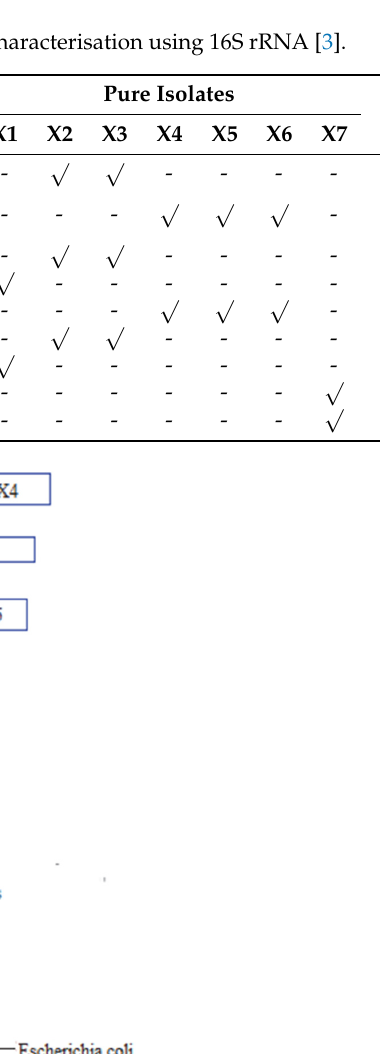
Table 3. Sludge Cr(VI)-Reducing Bacteria strain characterisation using 16S rRNA[3].